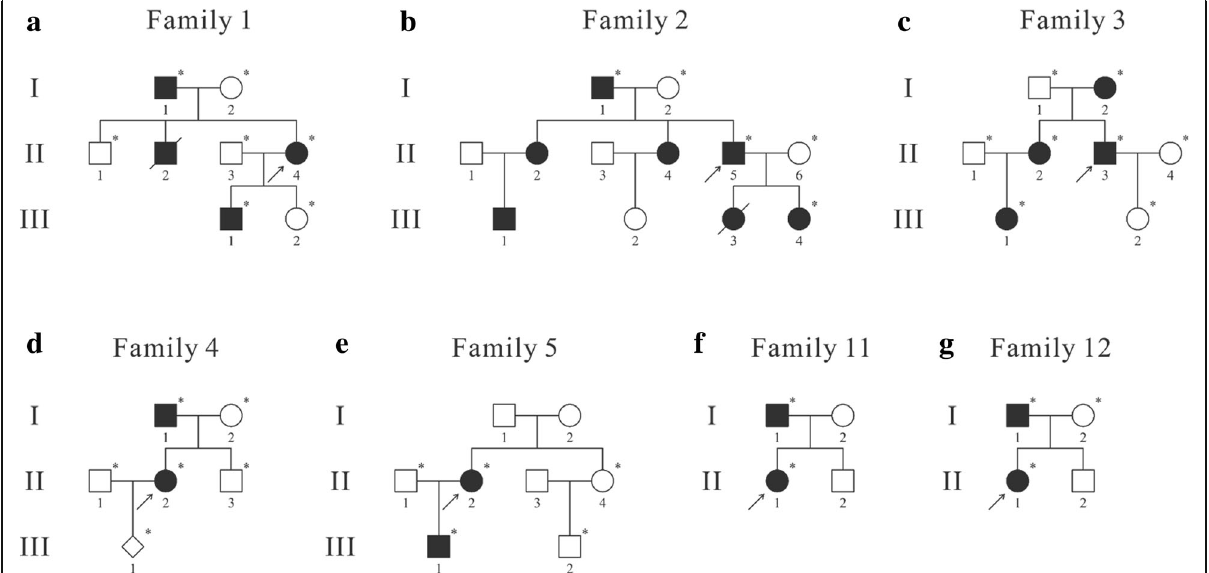
Fig. 1 Pedigrees of families with positive family histories. The arrows indicate the probands in each family. The asterisks denote that peripheral blood samples of individuals had been acquired. a - g : Pedigrees of Families 1 – 5 and 11 –